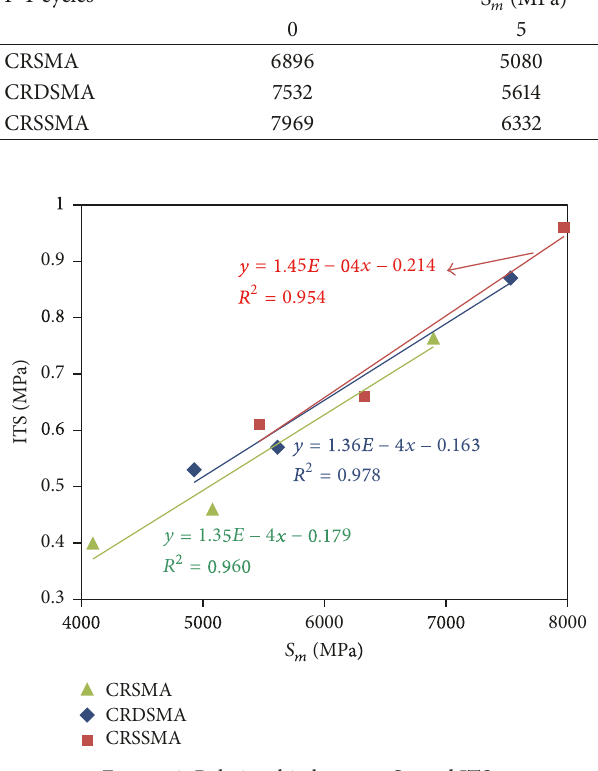
Figure 8: Relationship between 𝑆 𝑚 and ITS. Figure 9: Regression models of Δ ITS for CRSMA, CRDSMA, and